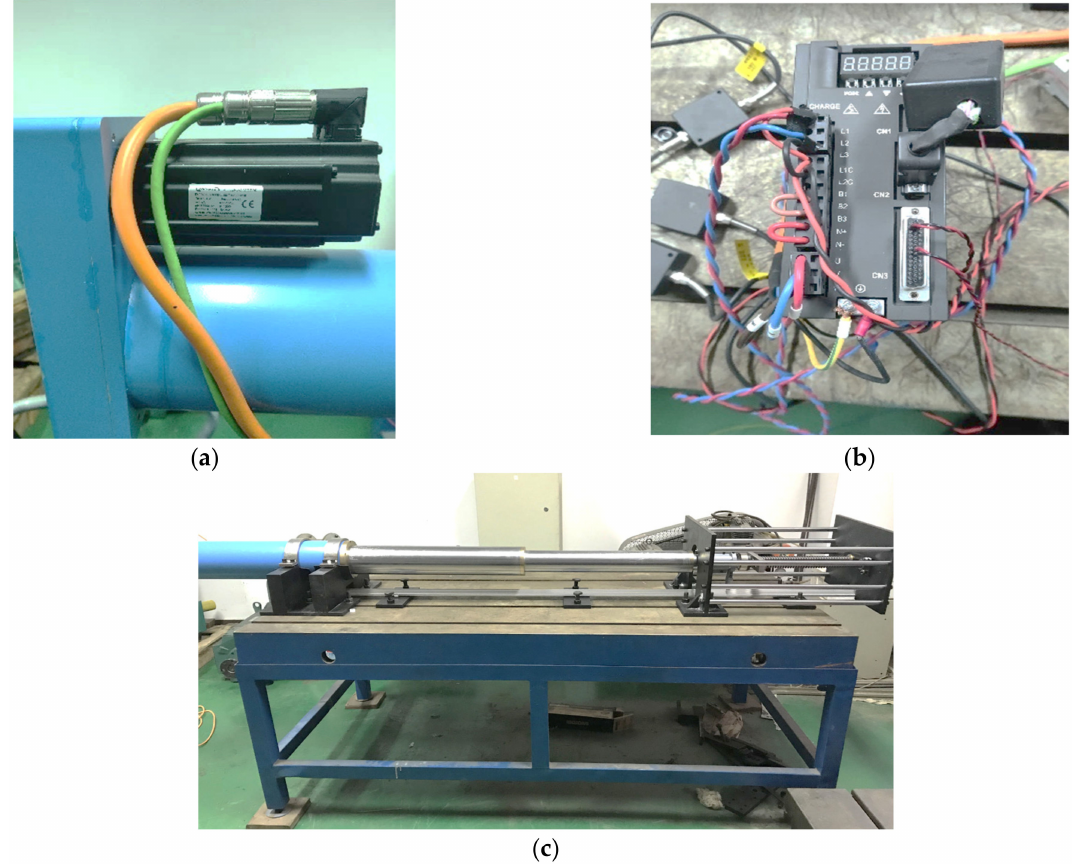
Figure 16. ( a ) PMSM; ( b ) Motor driver; ( c ) Three-stage actuating cylinder.